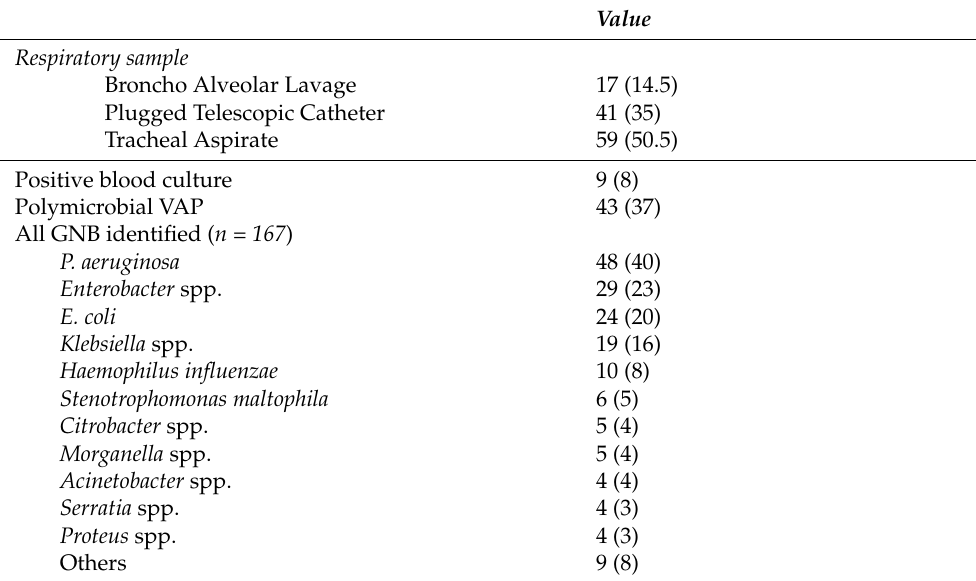
Table 2. Microbiological findings in the first respiratory sample obtained (before